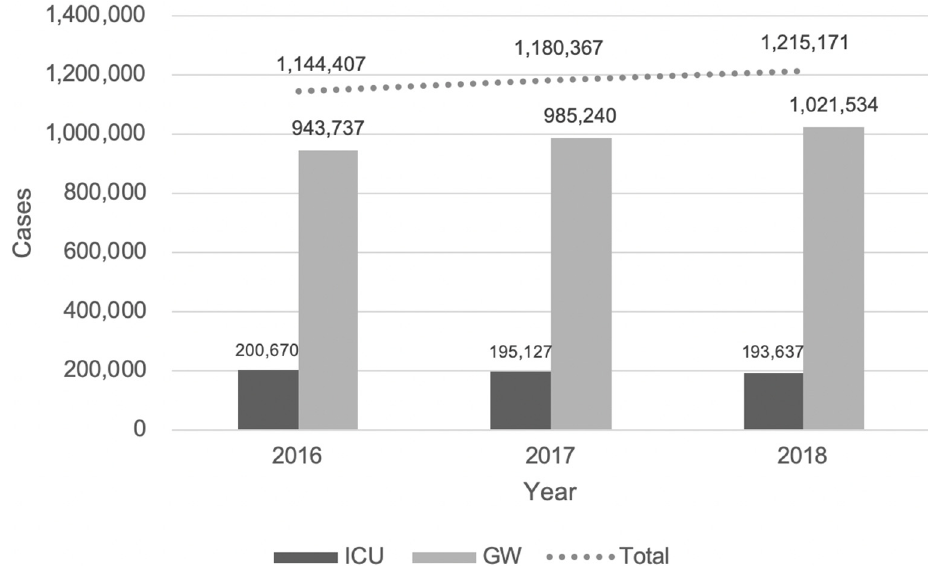
Figure 2. Trends of the total admission through the emergency department during the study period. ED, emergency department; GW, general ward; ICU, intensive care unit. Table 1. Baseline characteristics of the study